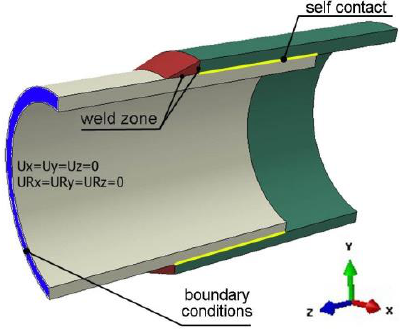
Figure 15. Scheme of contact area and mechanical boundary conditions.